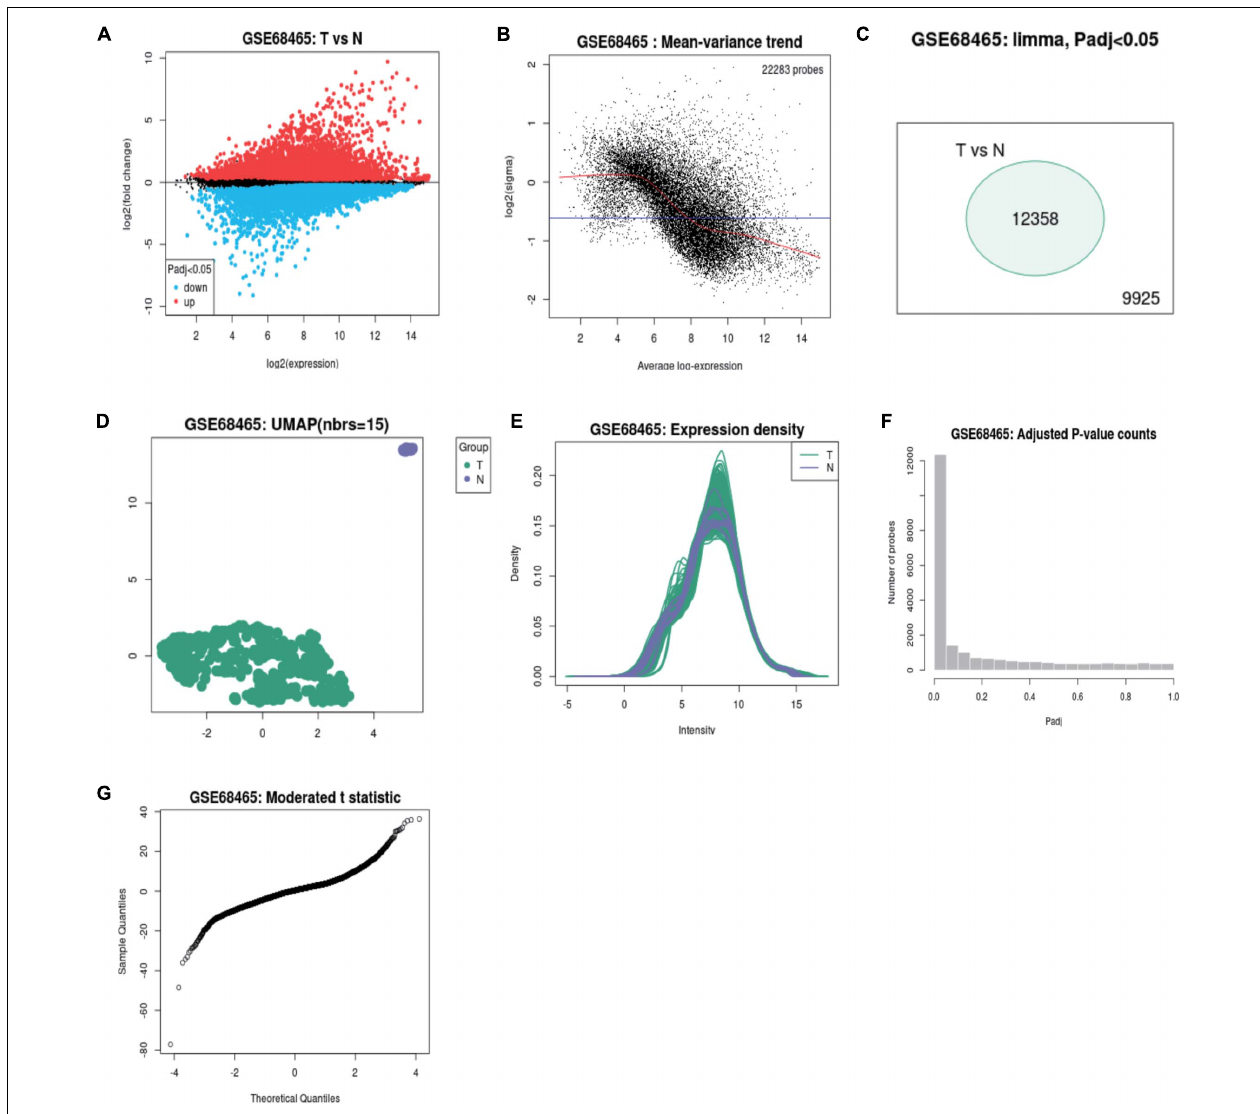
FIGURE 2 | The volcano map, scatter plot, peak plot of GSE68465 samples (A–G) .